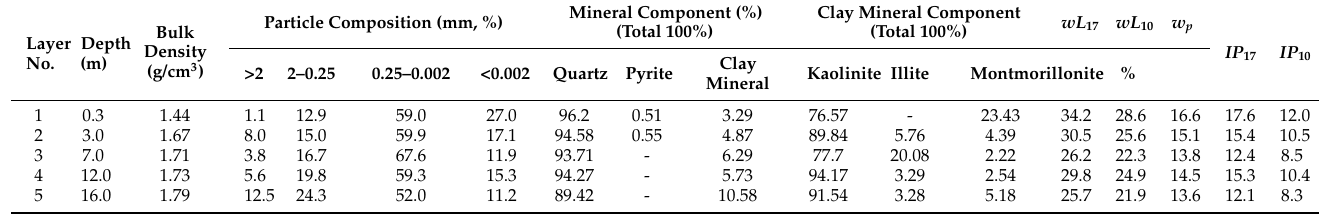
Table 1. Basic properties of soil samples.